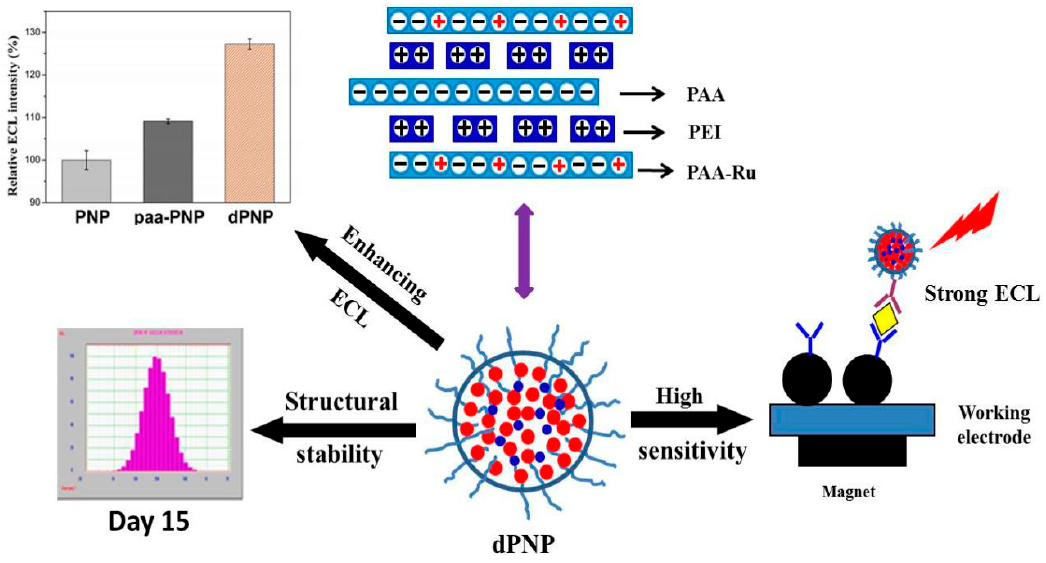
Figure 1. Schematic diagram of preparation of a doped polymer nanoparticle (dPNP), its electrochemiluminescence (ECL) enhancement and structural stability and principle of dPNP-based sensitive immune-assay. Here polymer nanoparticle (PNP) was the Ru(bpy) 32+ derivative-grafted polyacrylic acid (PAA–Ru) self-assembled nanoparticle, and paa-PNP was polyacrylic acid PAA doped PNP.